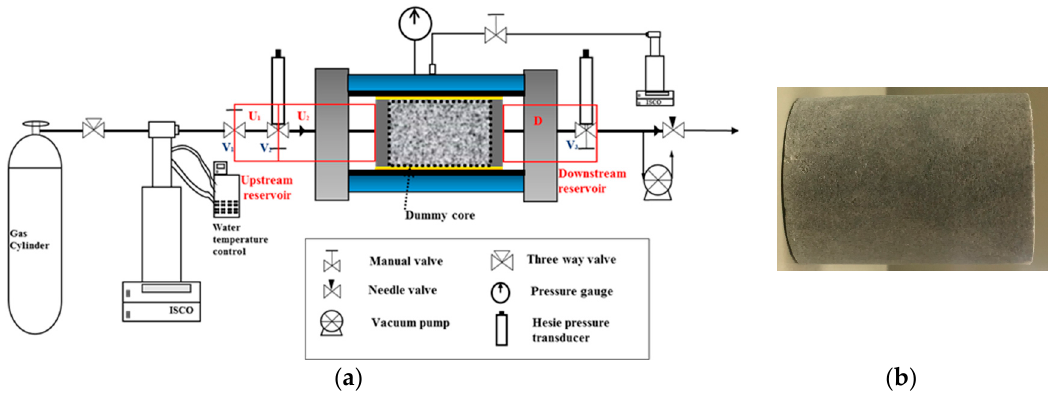
Figure 2. ( a ) Pulse-decay experimental set-up and ( b ) the core sample for the test.